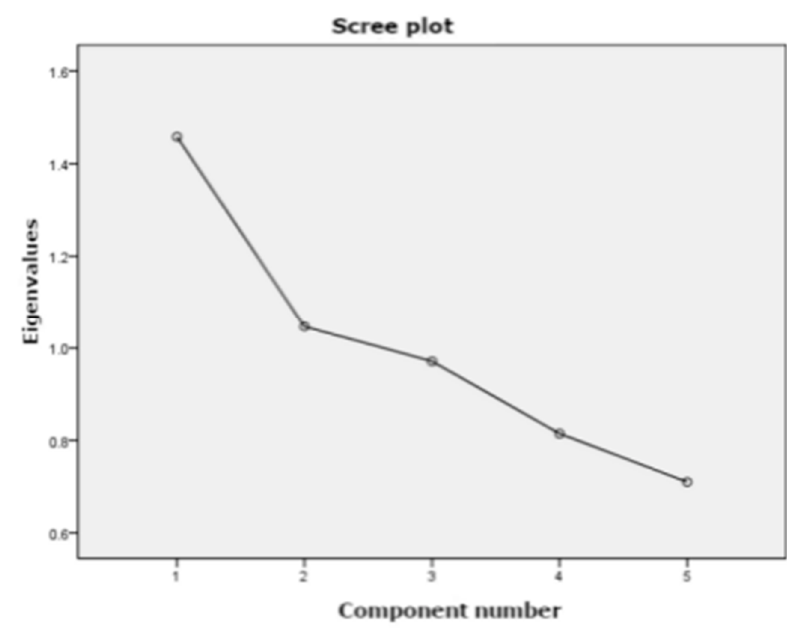
Figure 4. Scree plot.